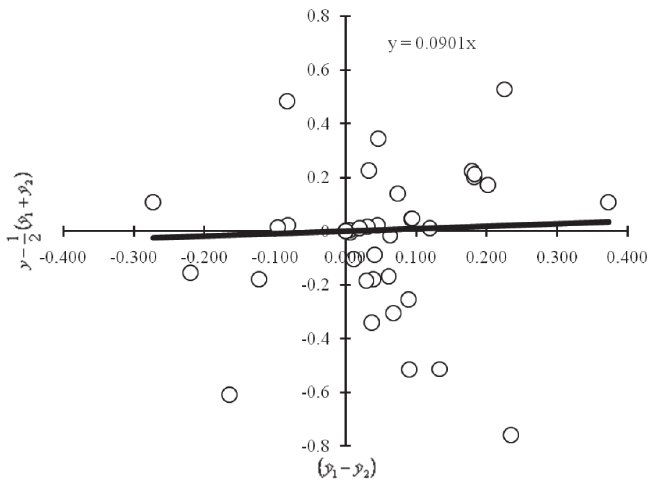
Fig. 3 – Application of the nonintrinsic parameter method for comparing the Lagergren model (1) and the pseudo-second order model (2) for Zn sorption on coal fly ash materials